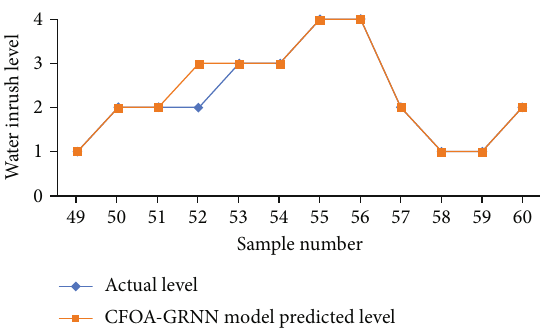
Figure 4: Prediction results of the CFOA-GRNN model.